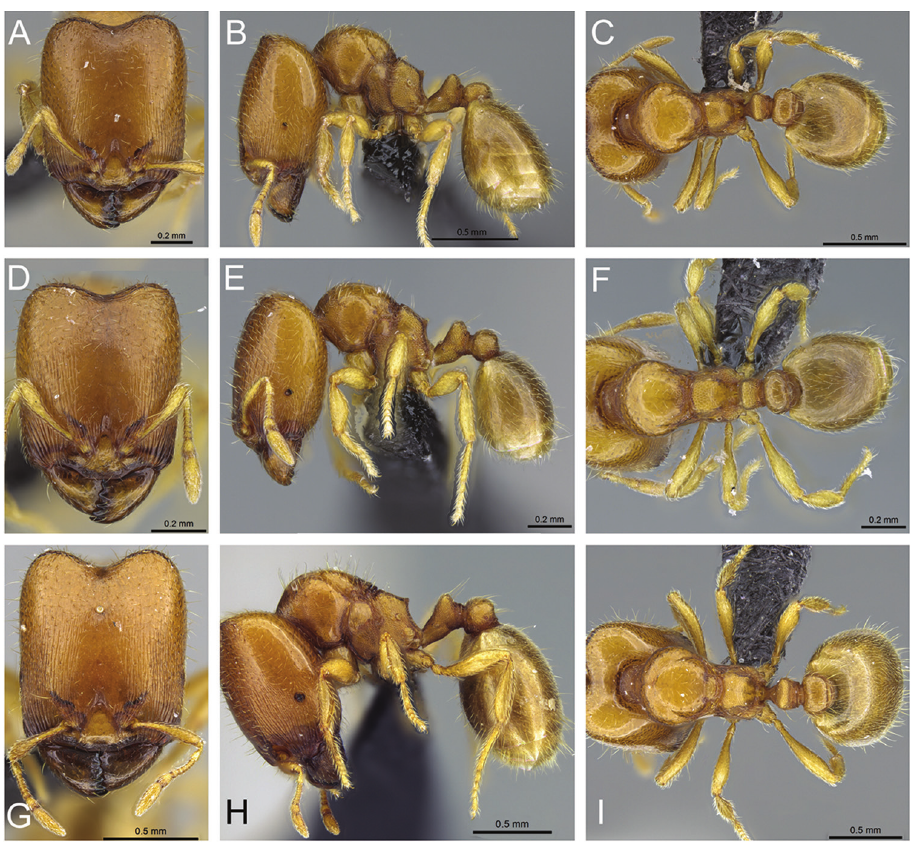
Figure 56. Intermediates of Carebara omasi . Major workers, CASENT0028955: A head in full-face view B body in profile view C body in dorsal view. CASENT0028862: D head in full-face view E body in profile view F body in dorsal view. CASENT0028870 G head in full-face view H body in profile view I body in dorsal